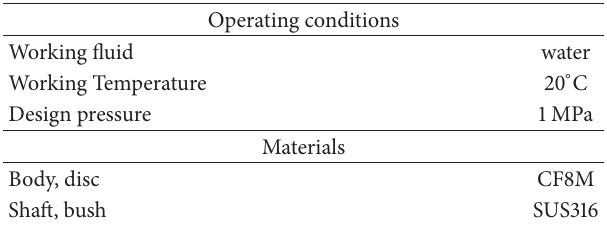
Figure 1: External appearance of the double-eccentric butterfly valve considered in the present study. Table 1: Operating conditions for the flow analysis and materials for the structural analysis.